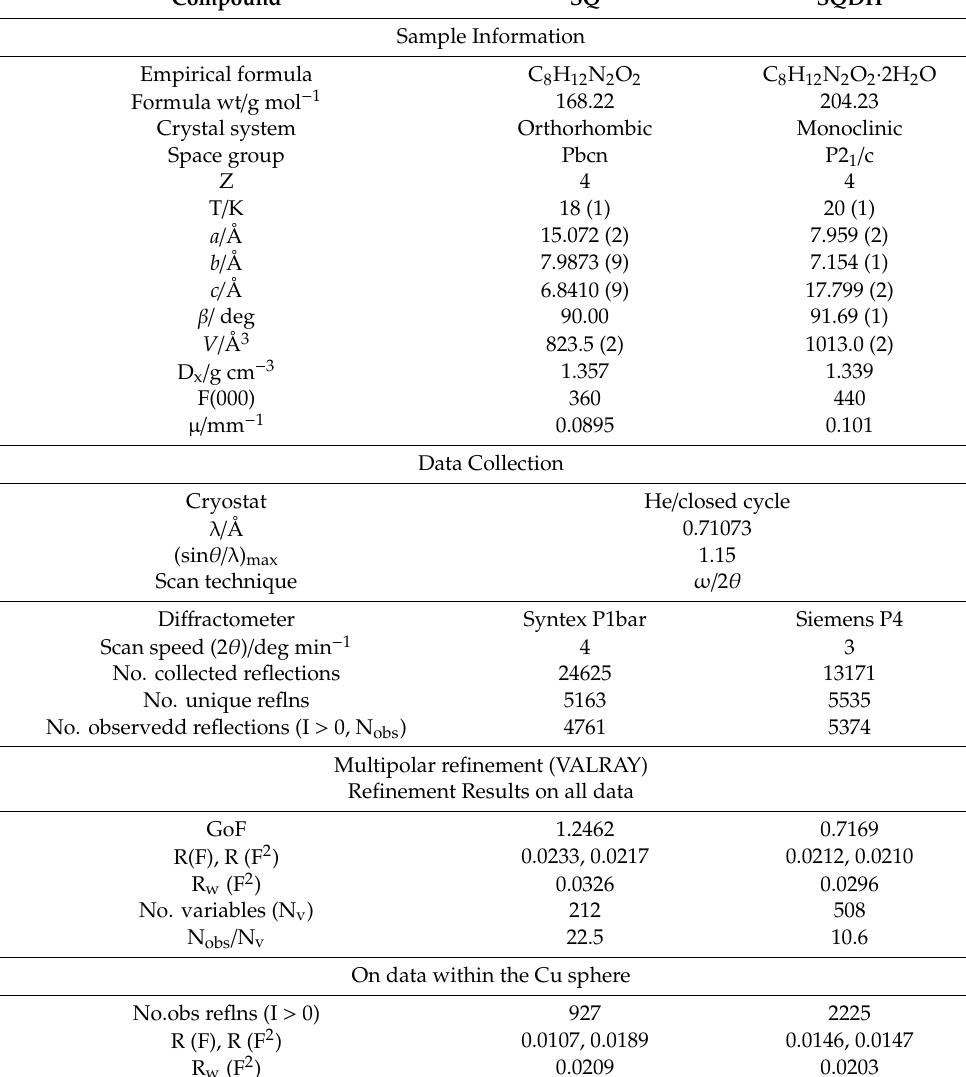
Table 2. Low-T crystal data of 1,3-bis(dimethylamino)squaraine (SQ) and its di-hydrate (SQDH). Compound